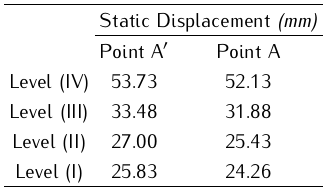
Table 4. Static (initial) displacement at center of crest in stream di- rection; NL-DCM